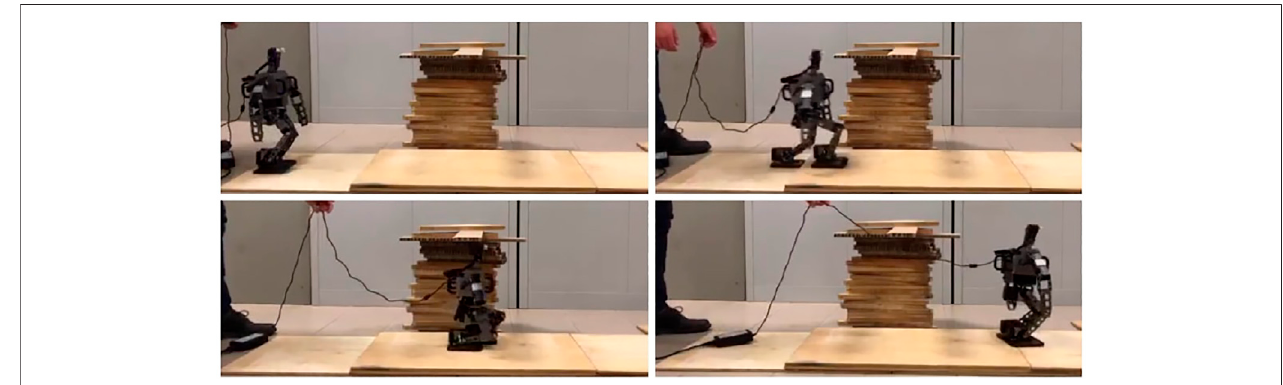
FIGURE15| Snapshotsfromtheexperiment.OP3walksforwardandstepsontoanelevatedgroundpatchthenloweritsCoMtocrouchinordertopassbelowan obstacle. The cable attached to the robot ’ s back is used for power supply only and does not sustain the robot while walking.